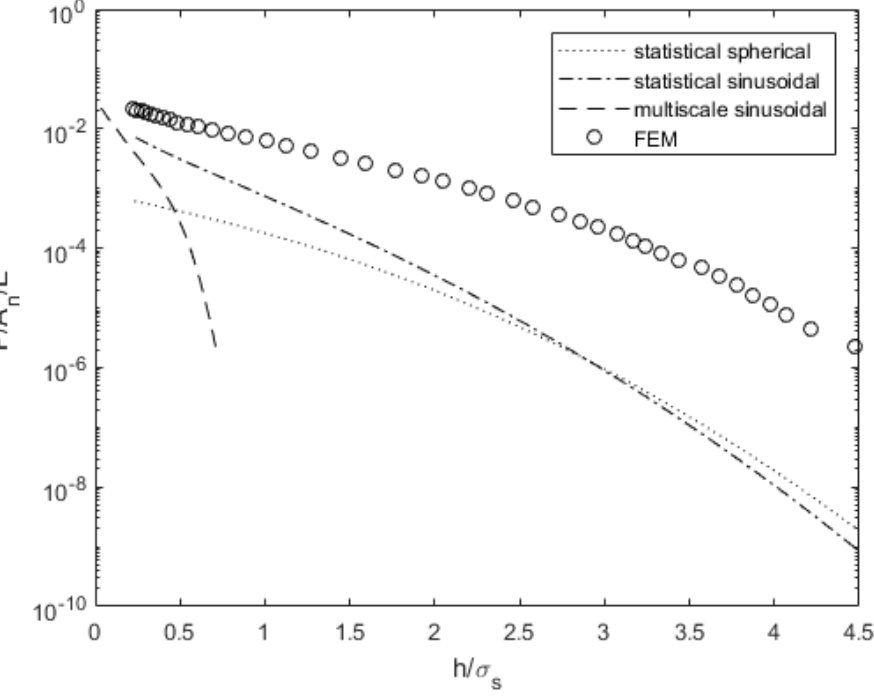
Figure 5. Load comparison dependent on surface separation for surface 4L.